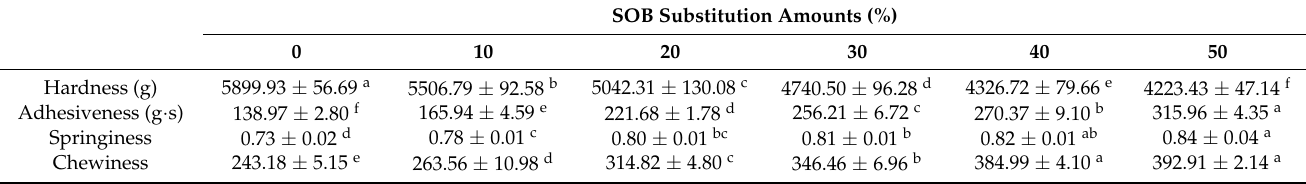
Table 2. Effects of different SOB substitution amounts on the texture properties of ice cream. SOB Substitution Amounts